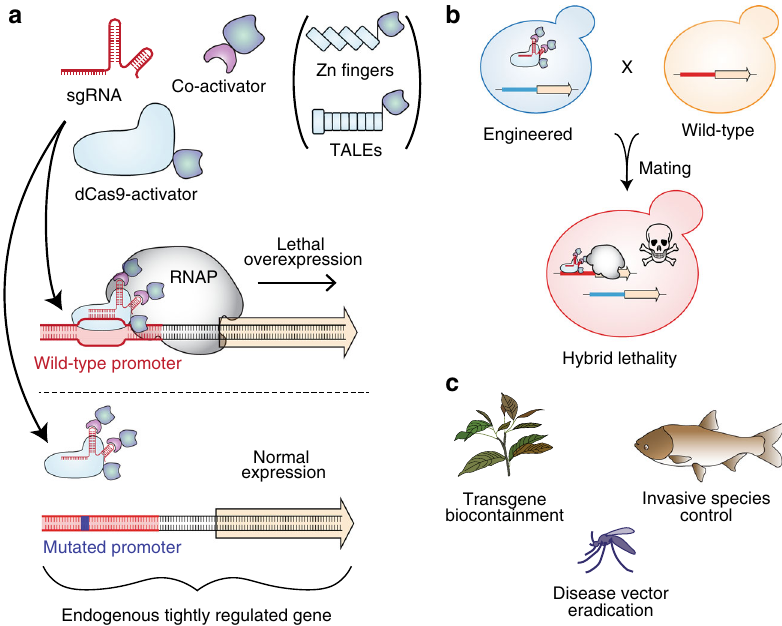
Fig. 1 Overview of synthetic incompatibility. a Macromolecular components that constitute programmable transcription factors (above), and schematic illustration showing lethal gene expression from a wild-type but not a refactored promoter (below). b Illustration of hybrid lethality upon mating of wild- type (orange cell) and SI (green cell) parents. Macromolecular components are labeled in a , red DNA signi fi es WT promoter, and blue DNA signi fi es refactored promoter. Skull and crossbones indicates a non-viable genotype. c Possible applications for engineered